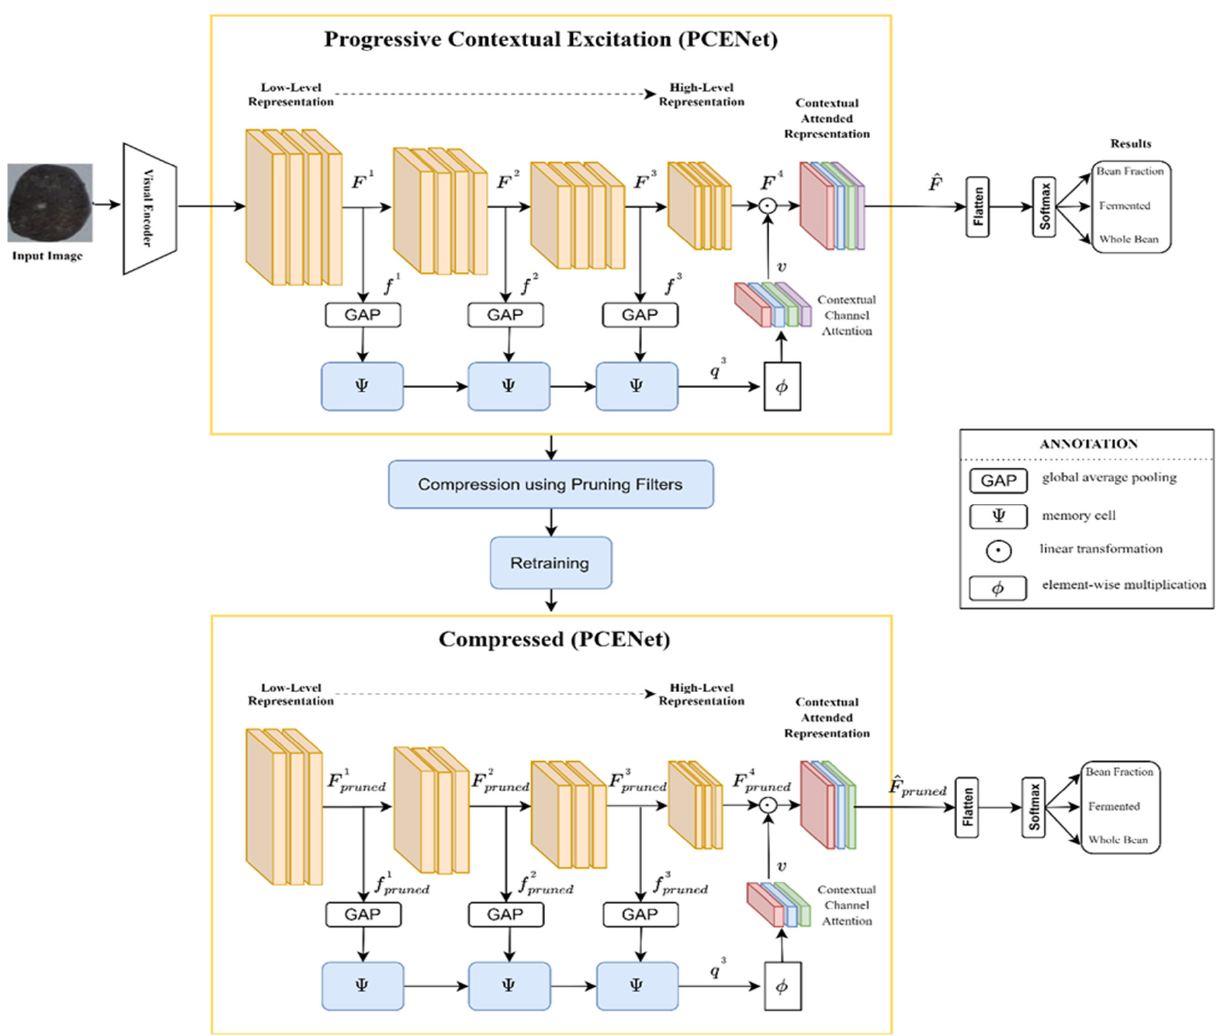
Figure 3. PCENet compression scheme. Table 1. Dimension comparison of each layer before and after pruning.